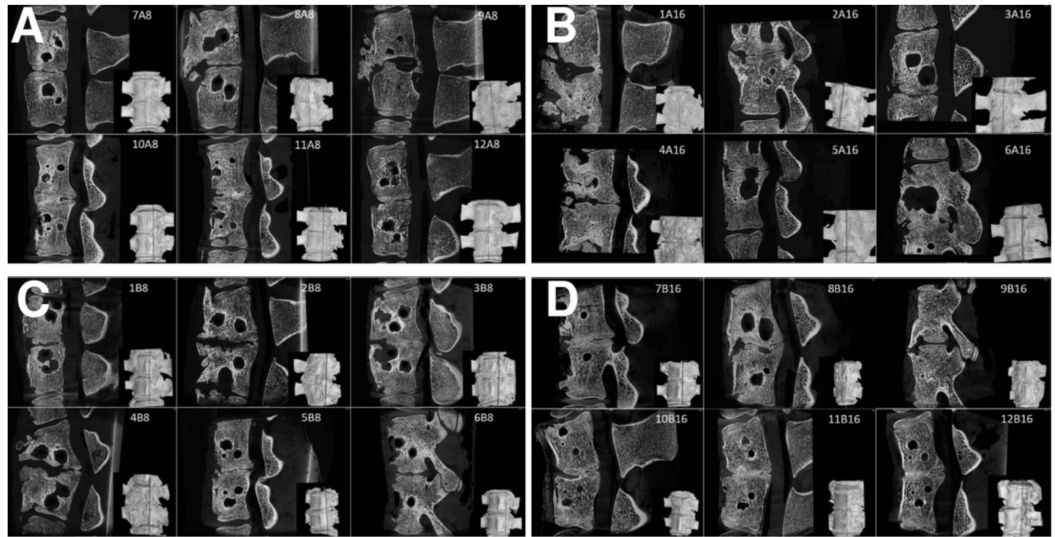
Figure 9. Sagittal micro-CT sections of the middle part of 6 samples from the Group A1 ( A ), Group A2 ( B ), Group B1 ( C ), and Group B2 ( D ), of the L2/3 section of pig spines. The plane of the section is recorded by a red line on the 3D reconstruction of the spine